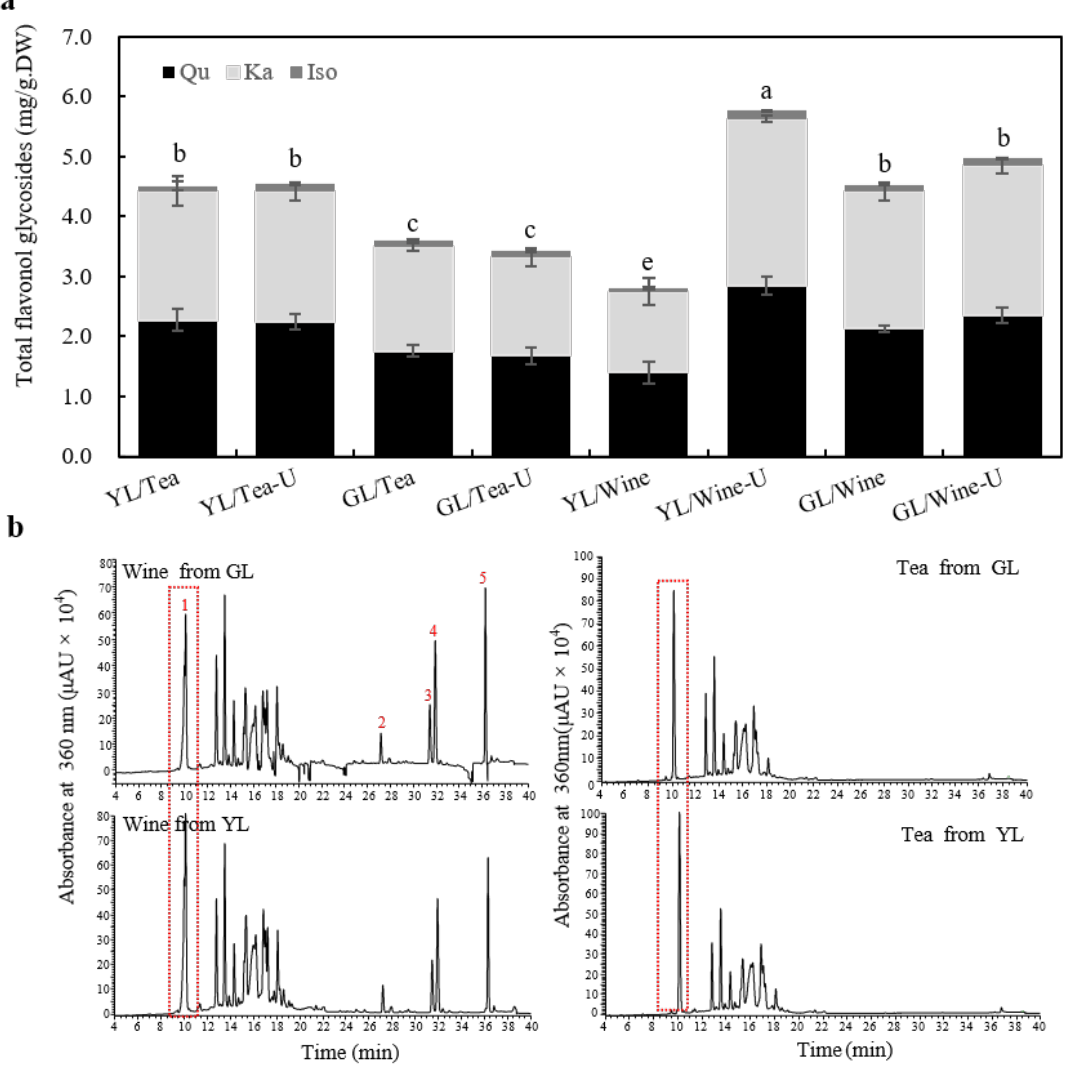
Figure 3. Analyses of the total flavonols in the ginkgo tea and ginkgo wine. ( a ) Total flavonol glycosides analyses of the ginkgo tea and ginkgo wine. Data are presented as mean ± SD. Different letters represent significantly different values with an alpha value at 0.05, n = 3. ( b ) HPLC chromatograms of ginkgo wine from GL powder (left, upper panel), YL powder (left, lower panel), ginkgo tea from GL powder (right, upper panel) and YL powder (right, lower panel) with ultrasound assistance. The red numbers in the chromatograms represent the peaks of specific compounds. (1) The specific age-related compound boxed at 9.94 min; (2) bilobetin; (3) ginkgetin, (4) isoginkgetin; (5) amentoflavone. Qu, quercetin-derived flavonol glycosides; Ka, kaempferol-derived flavonol glyco- sides; Iso, isorhamnetin-derived flavonol glycosides. Table 2. Measurement of the total flavonol (TF) concentrations in GBE drinks.